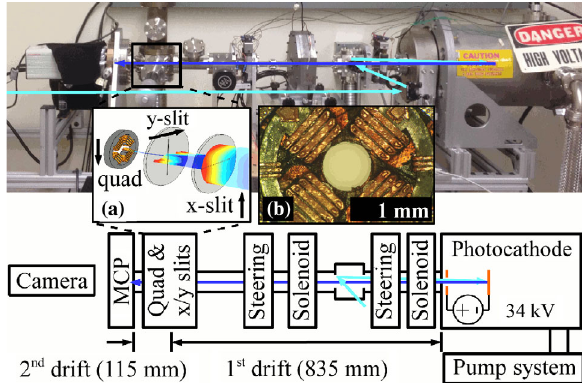
FIG. 9. Photograph and illustration of the electron beam experiment. Inset (a) shows an illustration of the inside of the experiment chamber with an electron beam (colored) entering the chamber from the right, striking a horizontal slit (x-slit) that is inserted into the chamber from below, a vertical slit (y-slit) that is inserted into the chamber from the left, and passing through a MEMS quadrupole (quad) that is inserted into the chamber from above. Inset (b) shows a photograph of a MEMS quadrupole. Cyan arrows illustrate the UV laser path from left to right and blue arrows illustrate the electron beam path from right to left.